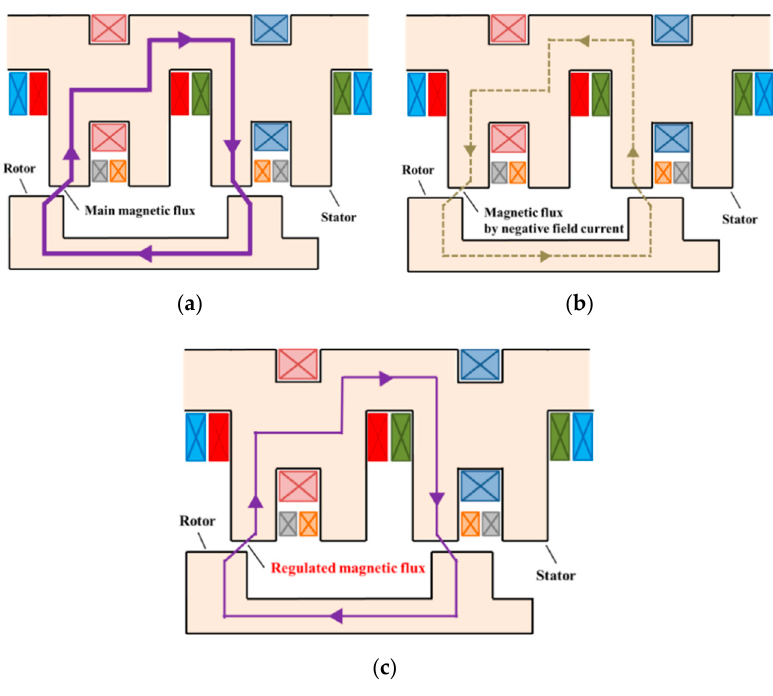
Figure 5. Flux regulation principle: ( a ) main magnetic flux by the NI HTS field coil, ( b ) magnetic flux by the additional field coil, and ( c ) regulated magnetic flux.